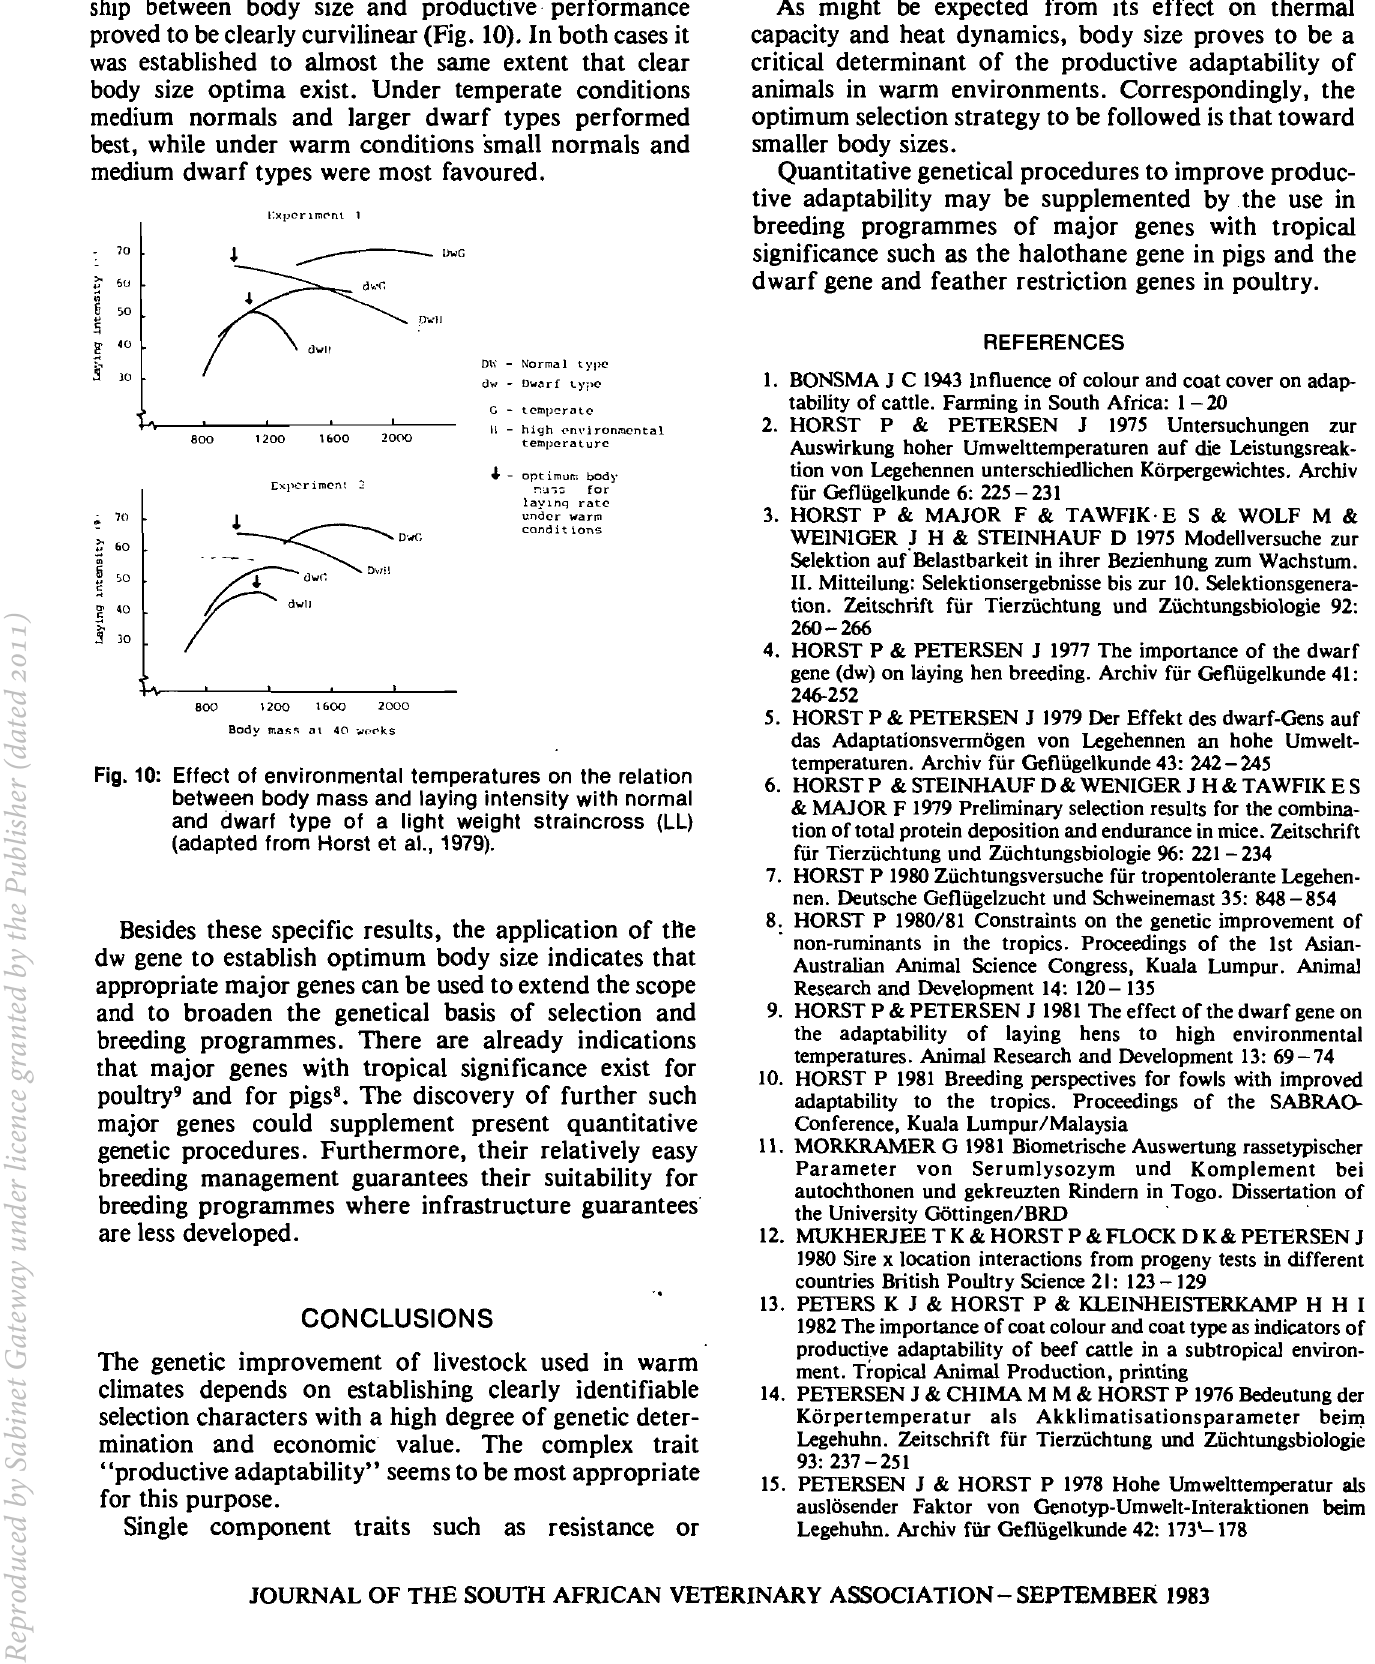
Fig. 10: Effect of environmental temperatures on the relation between body mass and laying intenSity with normal and dwarf type of a light weight straincross (LL) (adapted from Horst et aI.,